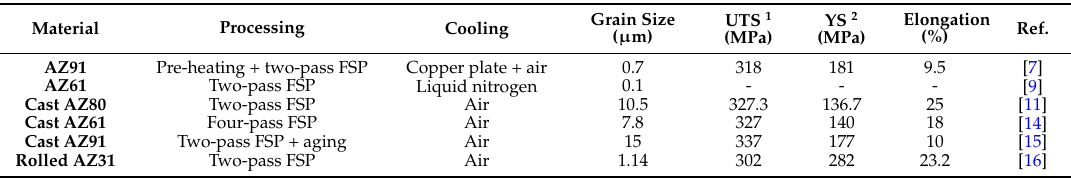
Table 1. The summary of magnesium alloys prepared through multi-pass friction stir processing (MFSP), with an overlapping ratio of 100% with different cooling